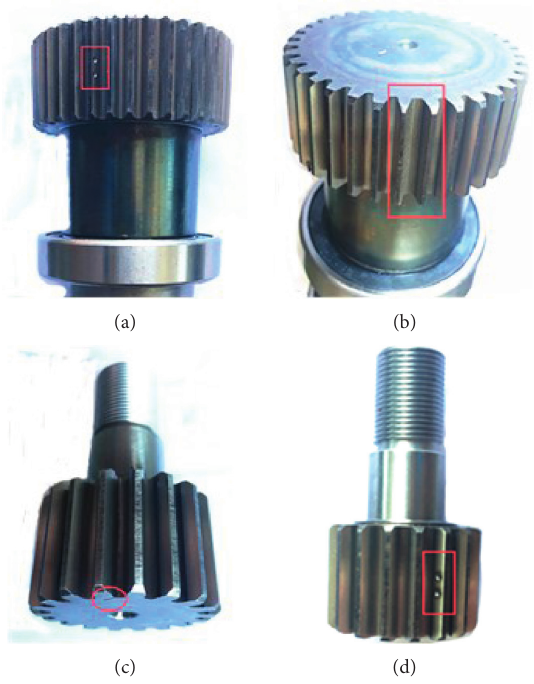
Figure 10: Four kinds of gear fault feature